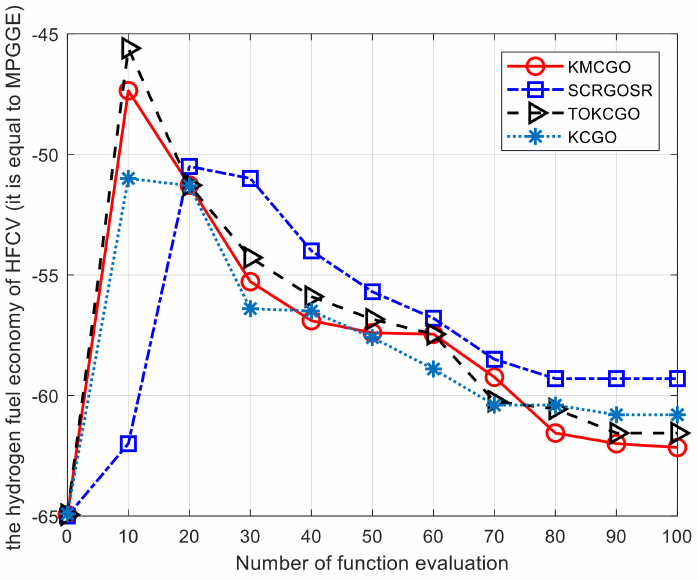
Figure 14. Control strategy parameter optimization